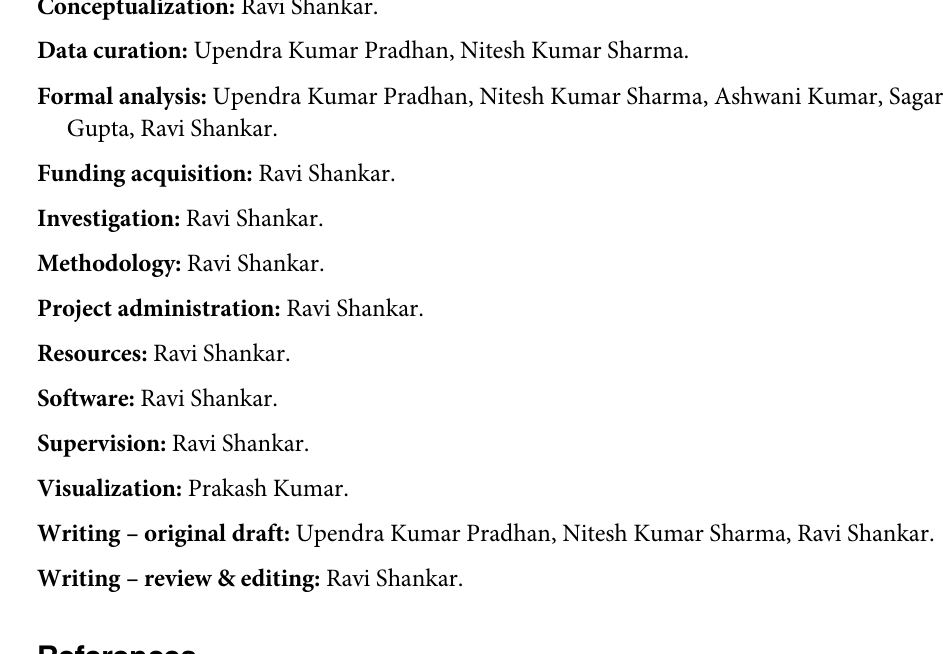
S4 Table. This table described number of Pri-miRNA and Pre-miRNA having binding site on each RBP out of 1,881 miRNAs. S5 Table. This table describes number of RBPs have binding sites in each Pri-miRNA and Pre-miRNA. S6 Table. Performance comparison among BNA based features, all initial input data for BNA(PPI) and shuffled feature set in terms of Accuracy, RMAPE and RMSE. S7 Table. Accuracy, RMAPE and RMSE values for validation set of 431